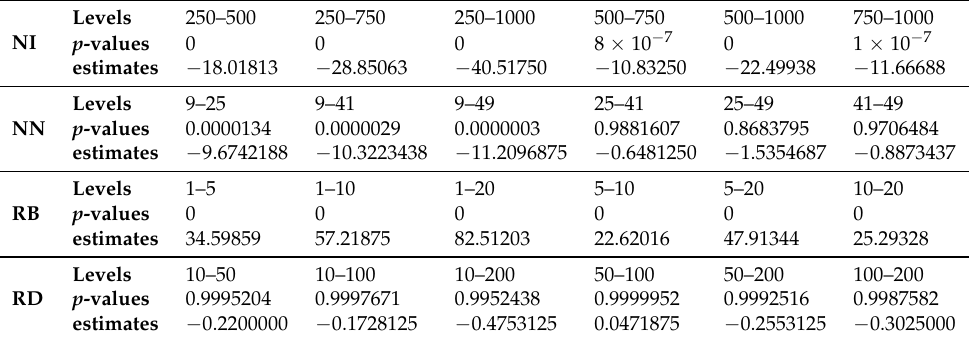
Table 2. Tukey’s honestly significant difference (HSD)